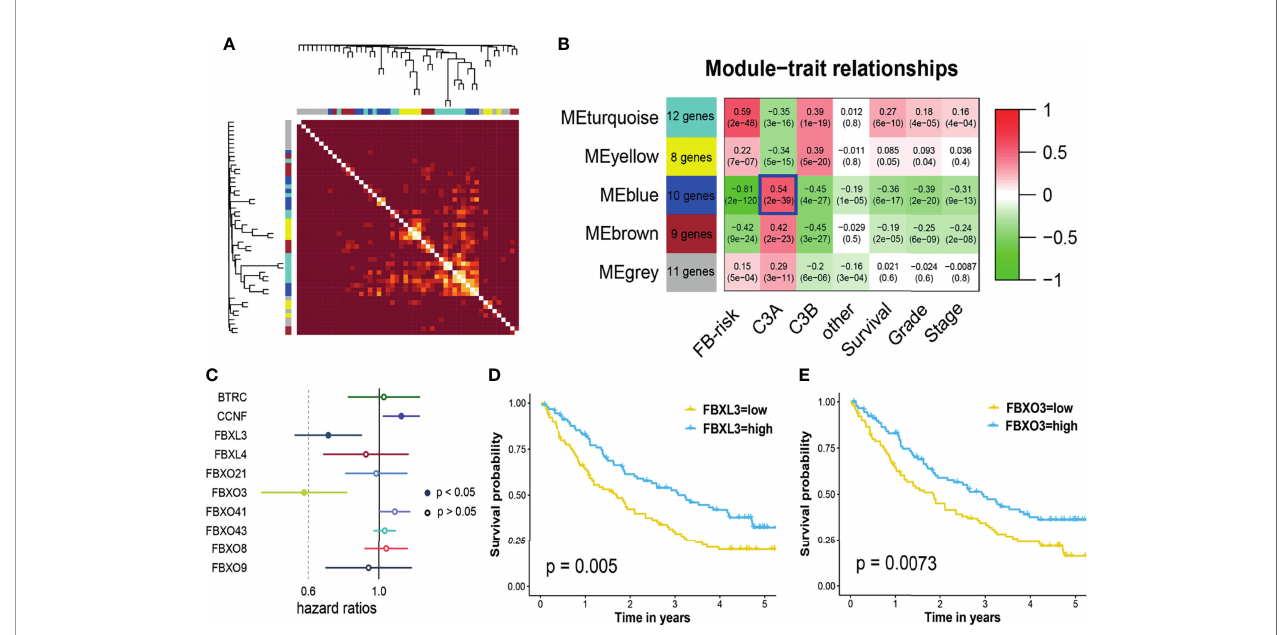
FIGURE 8 | Weighted gene co-expression network and core gene analysis in ccRCC of C3A cluster. (A) Heatmap illustrated the different gene dendrogram based on f-box family genes. (B) The relationship between gene modules and clinical characteristic. (C) Cox regression analysis of core genes in blue modules and known immunotherapy biomarkers, including TMB, PD-1, PD-L1, and PBRM1 mutation, for patients treated with ICIs. (D) Kaplan – Meier survival analysis of overall survival strati fi ed by the expression of FBXL3. (E) Kaplan – Meier survival analysis of overall survival strati fi ed by the expression of FBXO3. ccRCC, clear cell renal cell carcinoma; ICIs, immune checkpoint inhibitors; TMB, total mutation